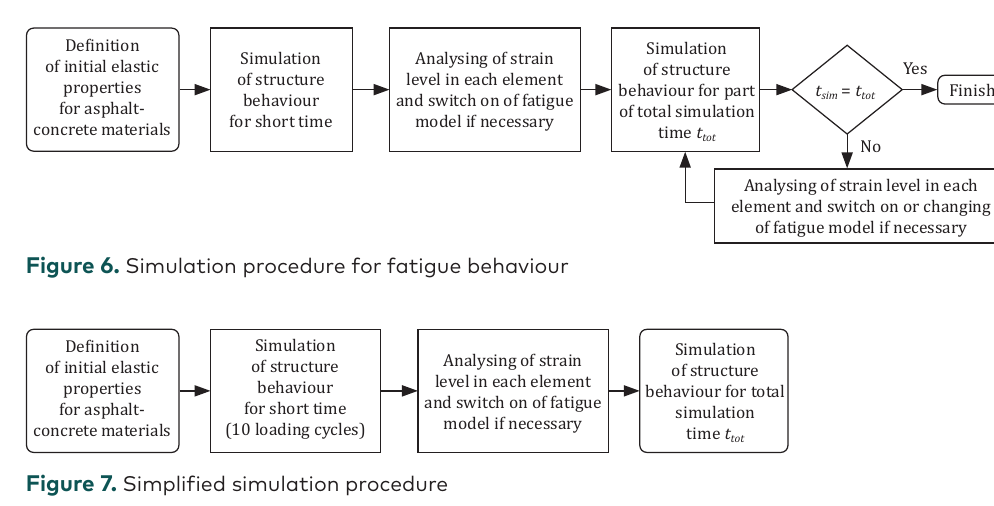
Figure 7. Simplified simulation